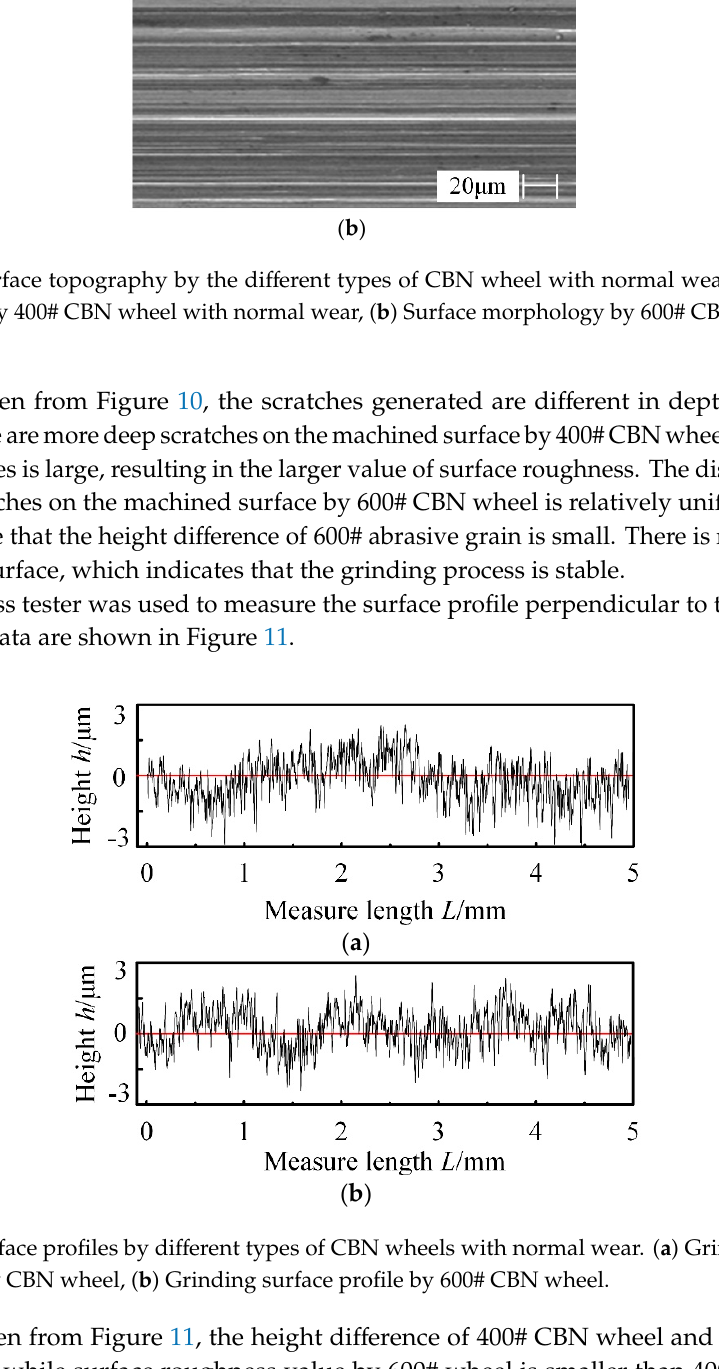
Figure 11. Surface profiles by different types of CBN wheels with normal wear. ( a ) Grinding surface profile by 400# CBN wheel, ( b ) Grinding surface profile by 600# CBN wheel.